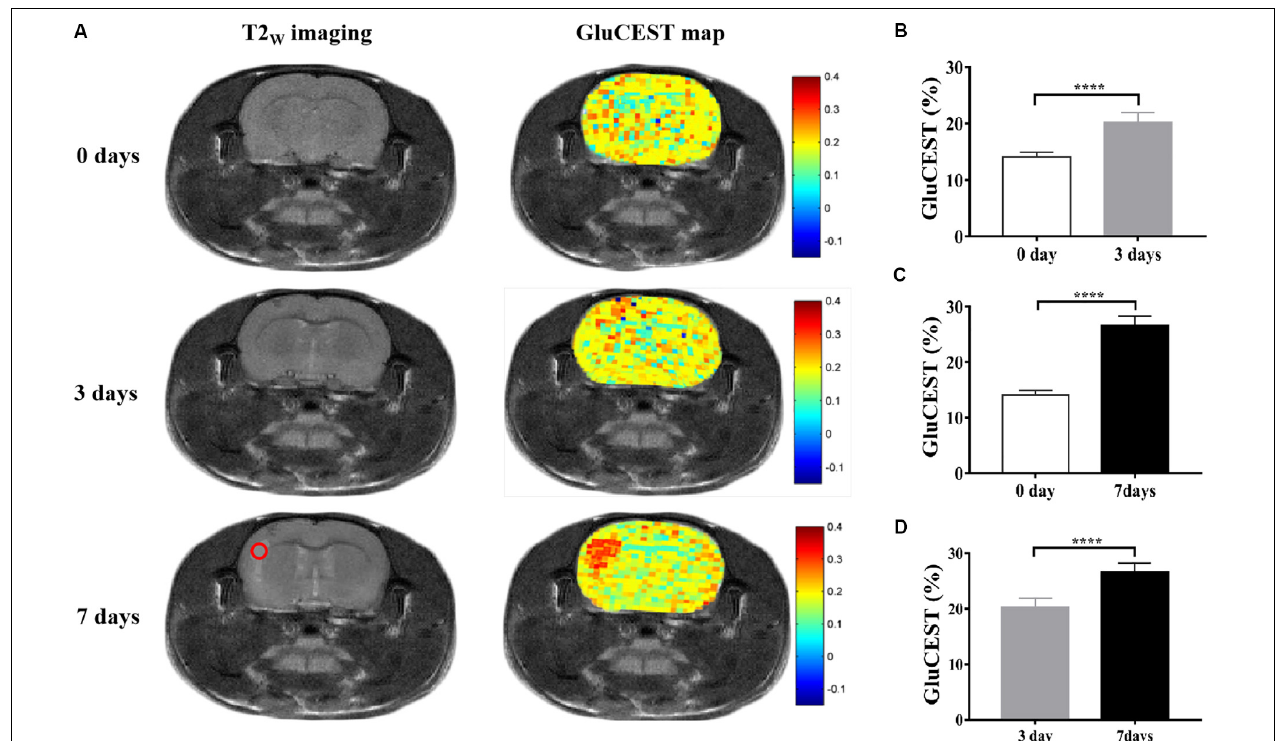
FIGURE 2 | Glutamate chemical exchange saturation transfer imaging in vivo in encephalitis rats. (A) T2 W imaging and GluCEST map of encephalitis rats with Staphylococcus aureus infections at different time points (0, 3, and 7 days), suggesting that the GluCEST signal was increased with increasing time; statistically